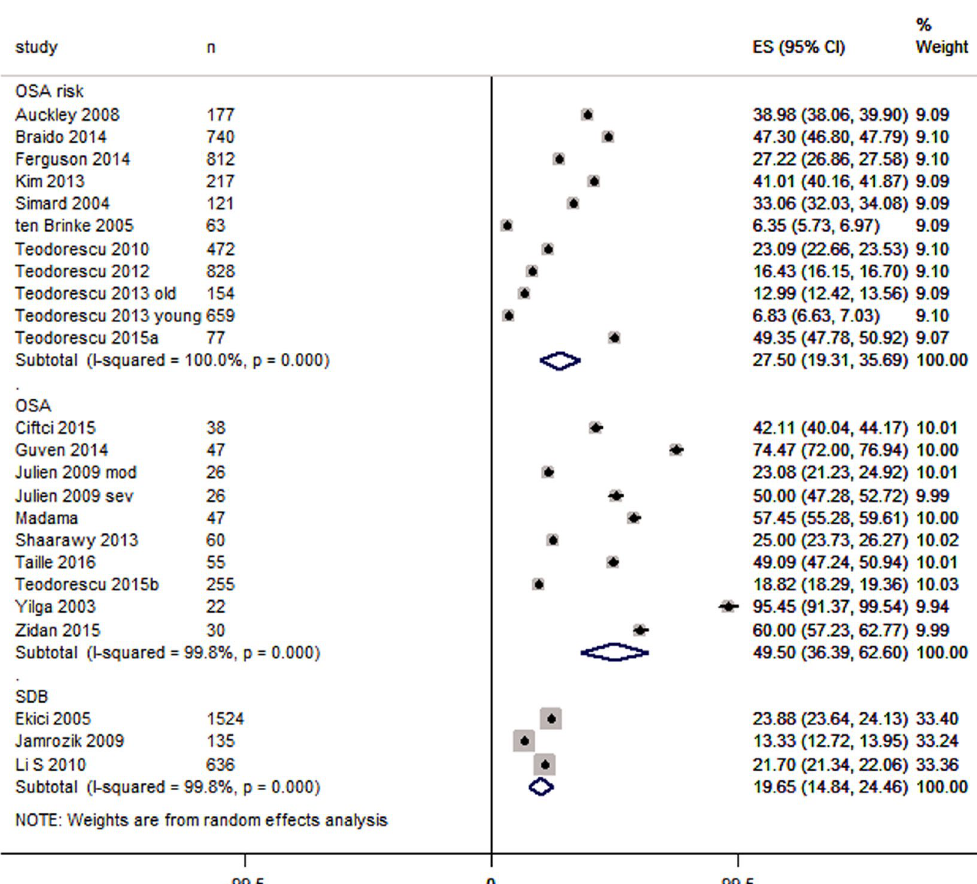
Figure 2. Forest graph showing the percent prevalence of OSA, OSA risk and SDB in asthma patients. Abbreviations in study identity: mo, moderate asthma, sev, severe